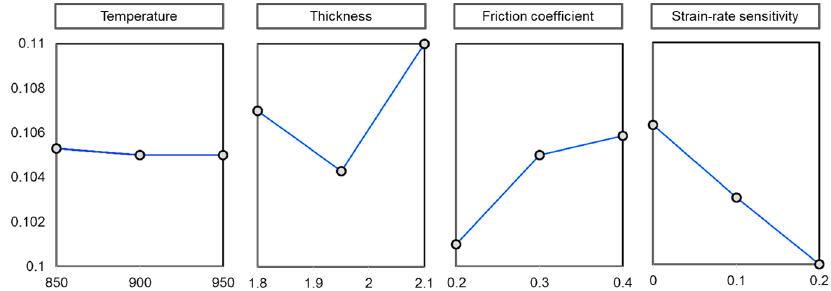
Figure 12. Effects of temperature, thickness, friction coefficient, and strain ‐ rate sensitivity on thick ‐ ness strain (main effects plot from Minitab).